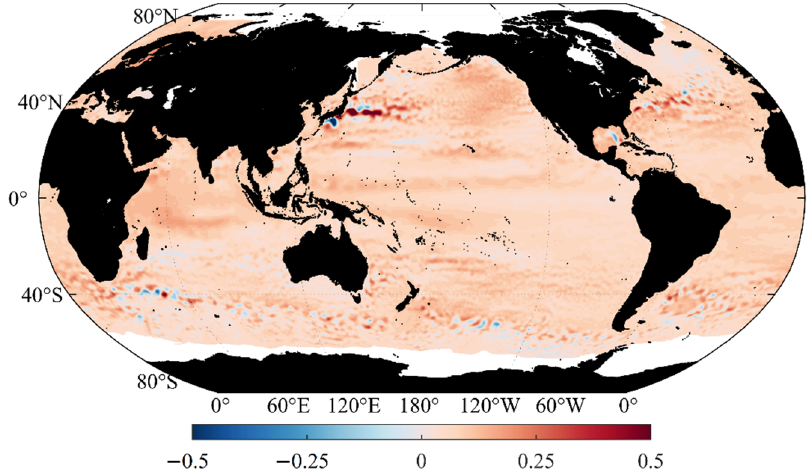
Figure 2. Global annual mean sea level anomaly in 2020 (unit: m).